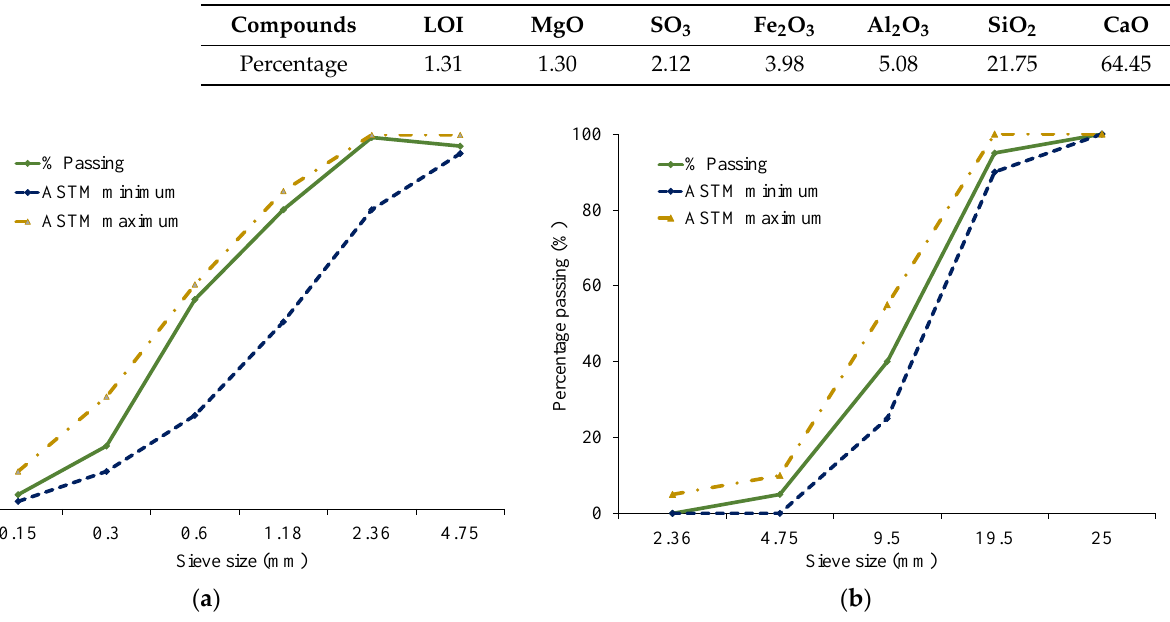
Figure 1. Sieve analysis of used aggregates ( a ) fine aggregates, ( b ) coarse aggregates. Table 1. Chemical properties of the used cement.